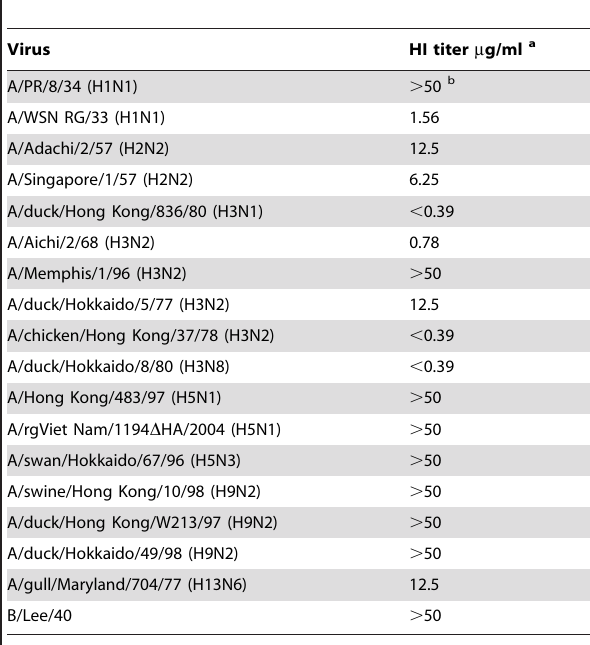
Table 1. HI activity of MAb S139/1 with various influenza virus